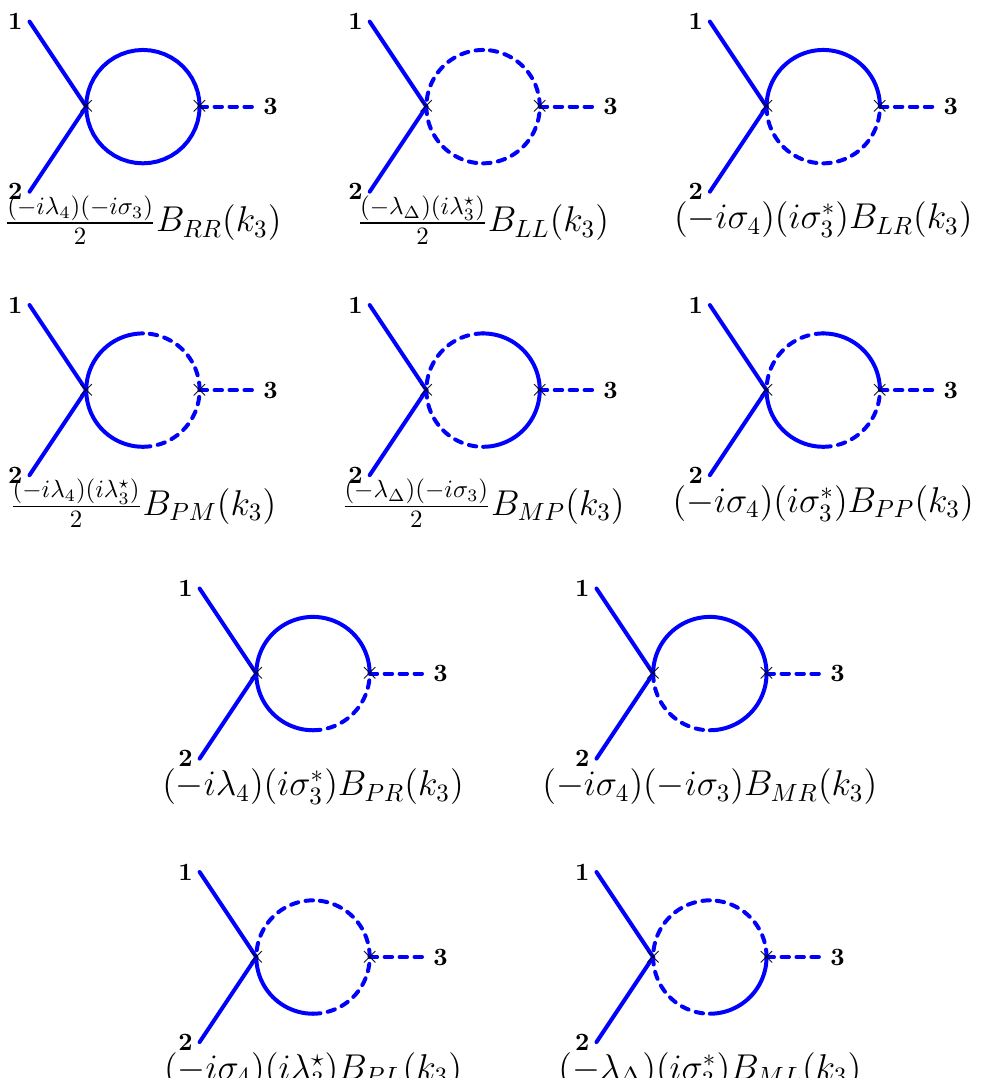
Figure 10. Diagrammatic representation of the Ten 1-Loop Integrals (cid:30) R (cid:30) R